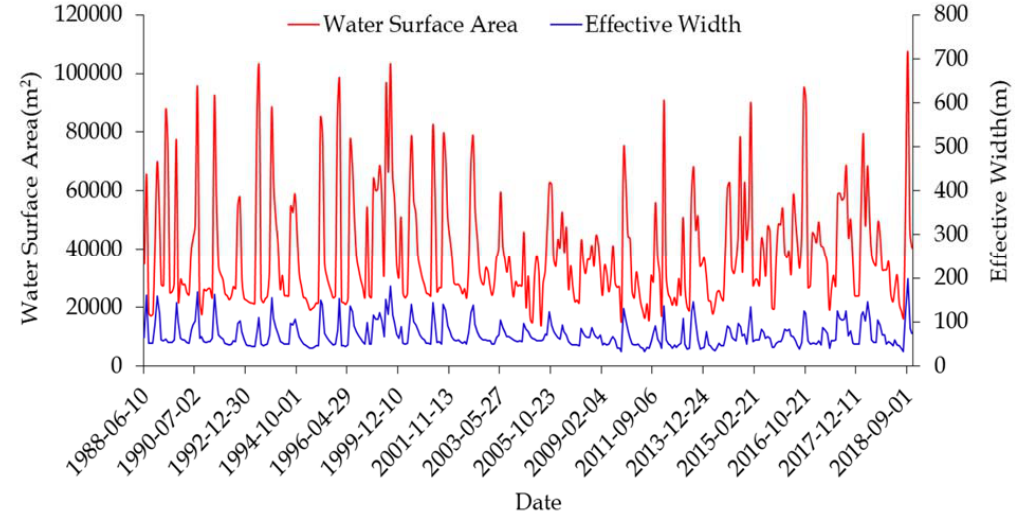
Figure 4. Time series of water surface area (WSA) and effective width derived from Landsat satellite imageries at Lhasa gauging station from 1988 to 2018.